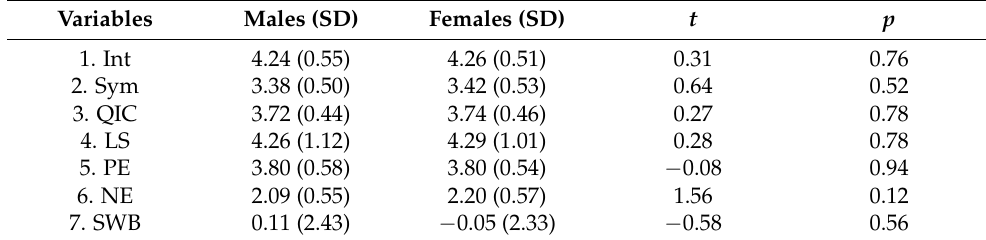
Table 2. Independent sample t test for gender